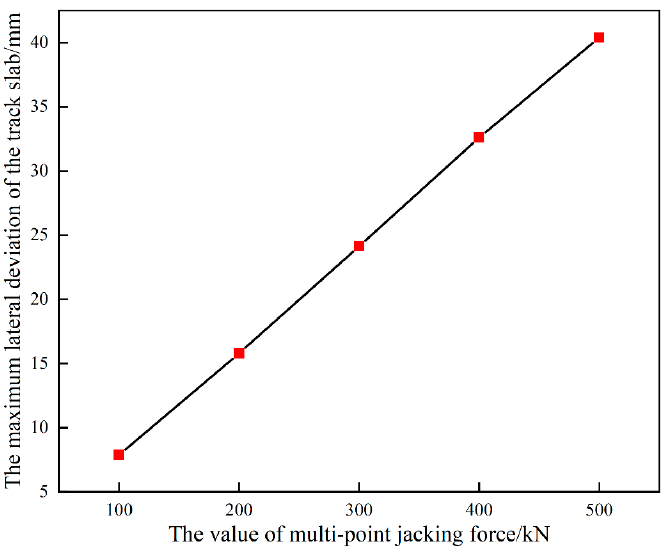
Figure 9. Maximum lateral deviation of track under different jack force.